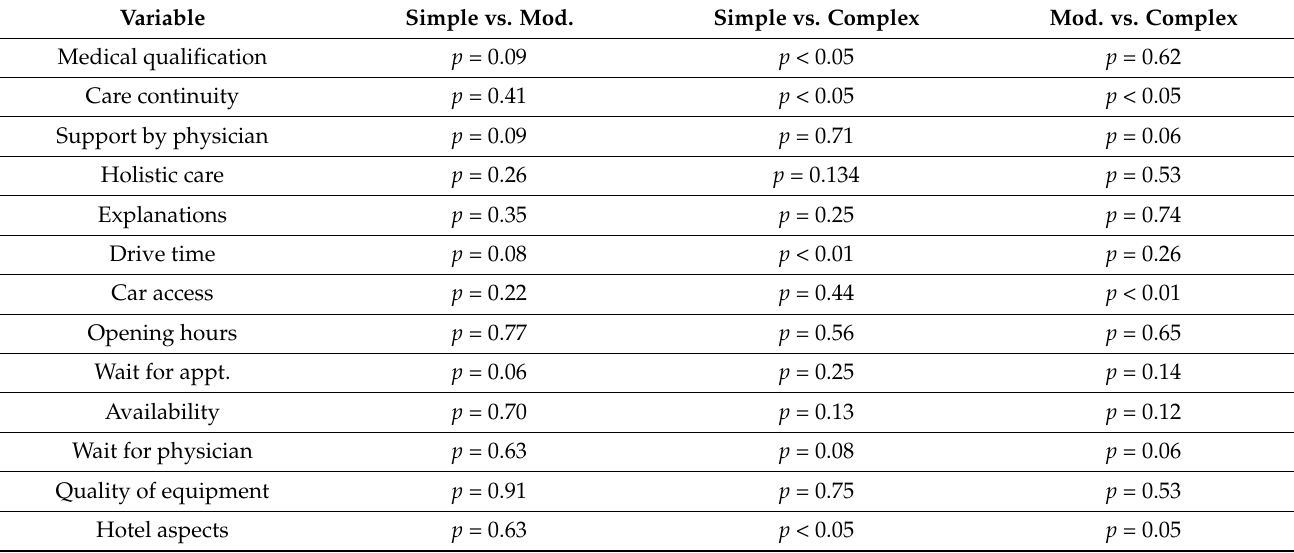
Table A1. Statistical comparison between various complexity levels of congenital heart disease, regarding importance of the 13 study parameters. appt. = appointment; Mod. =